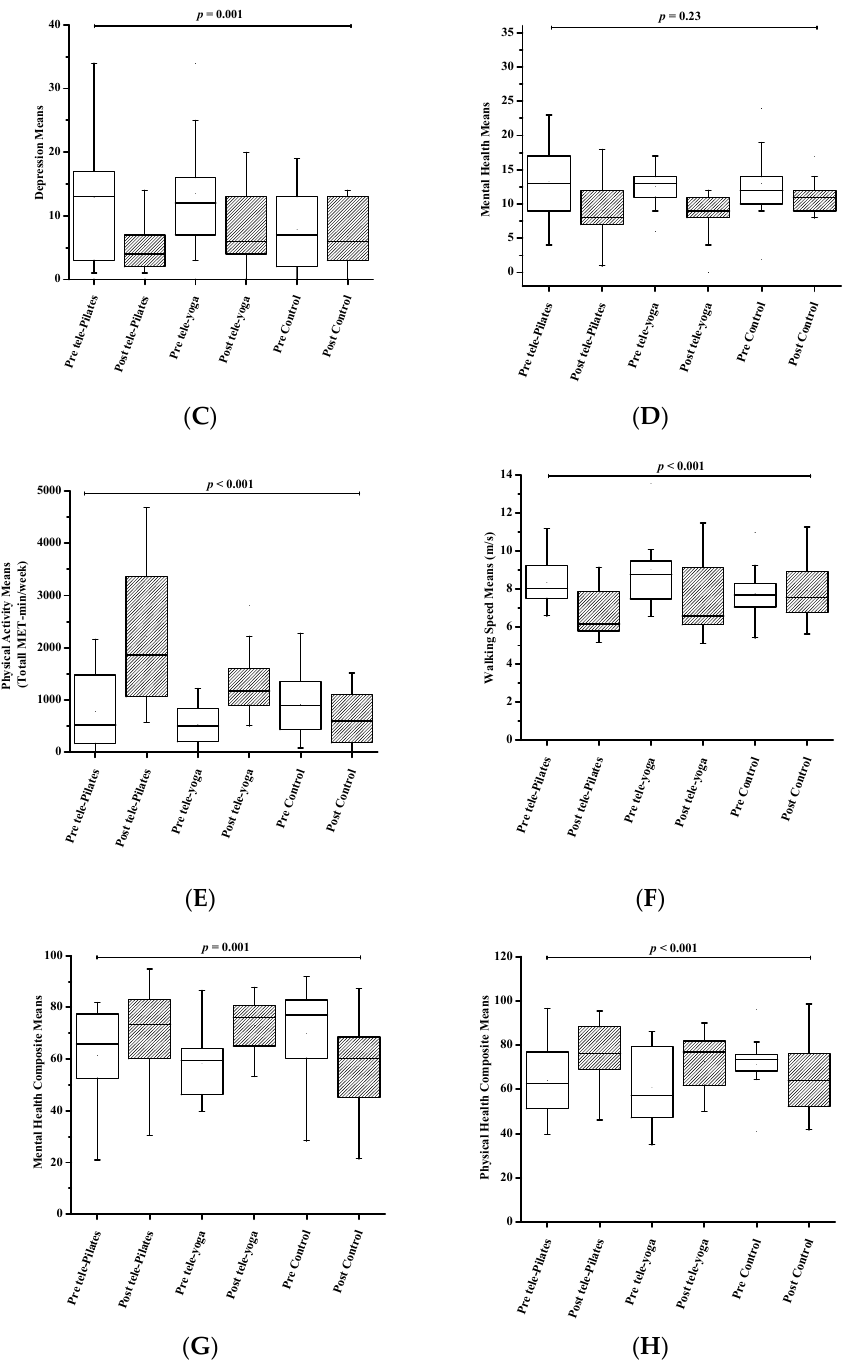
Figure 2. Changes in variables between groups during the 8 ‐ week period. Statistically significant ( p < 0.05); ( A ) prolactin serum level (ng/mL); ( B ) cortisol serum level (mcg/dL); ( C ) beak depression intro ‐ vertly (IBD) score: 1 ≤ these ups and downs are considered normal ≤ 10; 11 ≤ mild mood disturbance ≤ 16; 17 ≤ borderline clinical depression ≤ 20; 21 ≤ moderate depression ≤ 30; 31 ≤ moderate depression ≤ 40; 31 ≤ severe depression ≤ 40; over 40 extreme depression; ( D ) general health questioner (GHQ ‐ 12) score = 0 ≤ perfect ≤ 6; 7 ≤ good ≤ 12; 13 ≤ fairly good ≤ 18; 19 ≤ not bad ≤ 24; 25 ≤ bad ≤ 30; 31 ≤ extremely bad ≤ 36; ( E ) international physical activity (IPAQ) score: vigorous physical activity = total MET ‐ min/week > 1500; moderate physical activity = 4 80 ≤ total MET ‐ min/week ≤ 1500; passive(in ‐ active) = total MET ‐ min/week ≤ 480; ( F ) speed of walking (T25FW) (s); ( G ) mental health composite score; ( H ) physical health composite score.